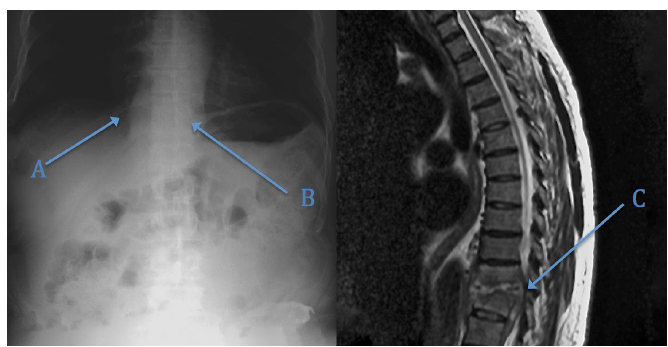
Figure . Magnetic resonance imaging of thoracic spine. Upright abdominal image demonstrating (A) paraspinal soft tissue density at the T10-T11 level worrisome for the possibility of paraspinal abscess, (B) poor visualization of the T10-T11 disc interspace, and (C) MRI demonstrating findings consistent with diskitis and associated sub-ligamentous abscess extending into the spinal canal at T11 and T12 with cord compression and severe central canal stenosis at these